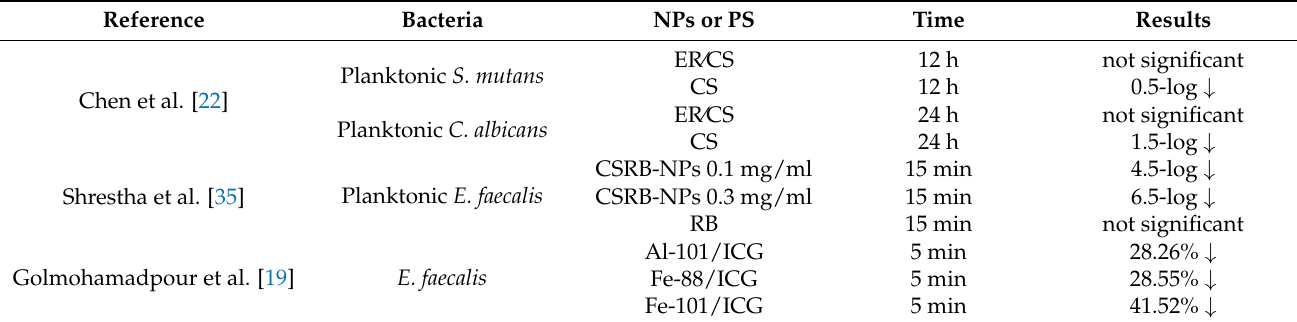
Table 5. Antibacterial efficacy in absence of